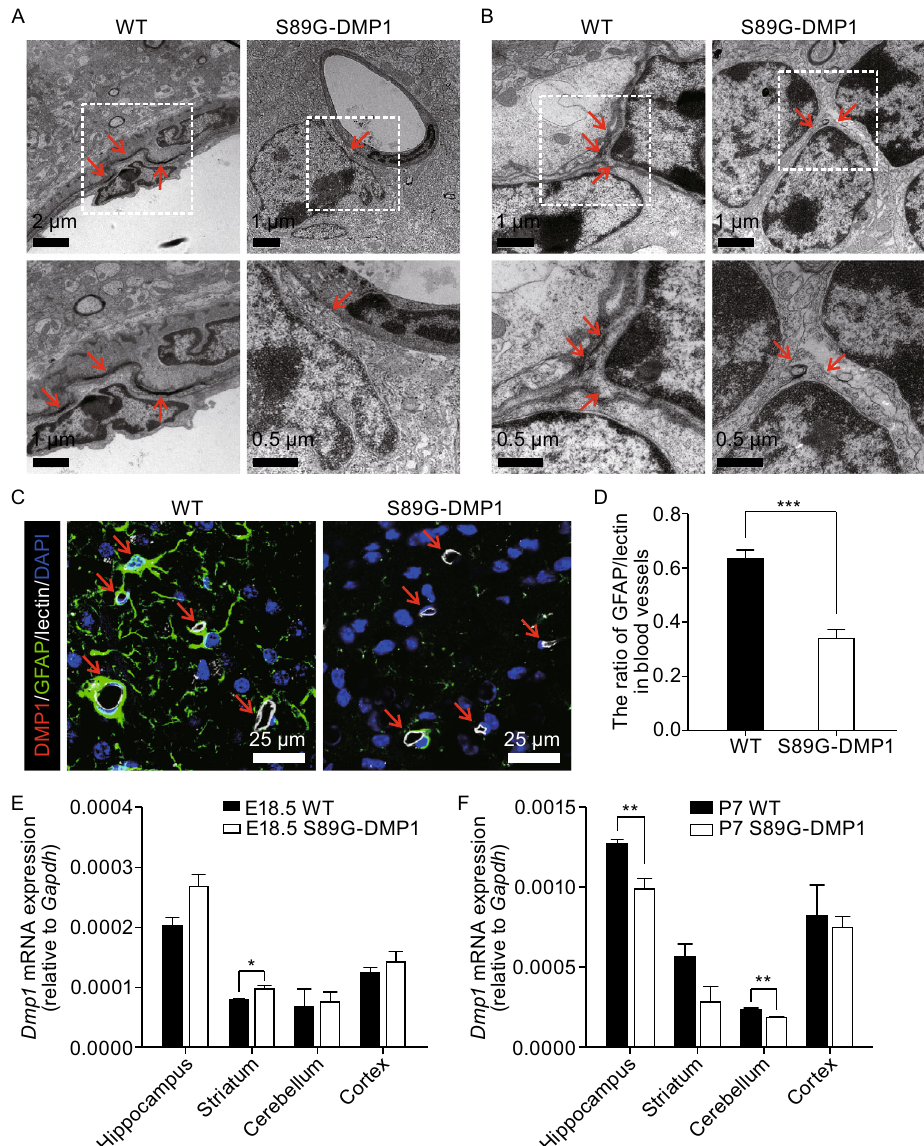
Figure 2. S89G-DMP1 inhibits astrocytes to locate to and wrap around blood vessels. (A) Transmission electron microscope showed loosened cell adhesion between astrocytes and vascular endothelial cells in the retrosplenial granular cortex (RSG) of S89G- DMP1 mice; and between astrocytes themselves (B); (C) Representative images of GFAP/lectin in the RSG, indicative of attenuated targeting of astrocytes to blood vessels in S89G mice; (D) Quanti fi cation plot for (C). ***, P < 0.001. At least 23 random captures from 7 mice per genotype were quanti fi ed. (E) Dmp1 mRNA decreased in different brain regions at embryonic Day 18.5 ( P ≤ 0.05 vs. WT) and (F) at postnatal Day 7 ( P ≤ 0.01 vs. WT). n = 3 – 4 mice per